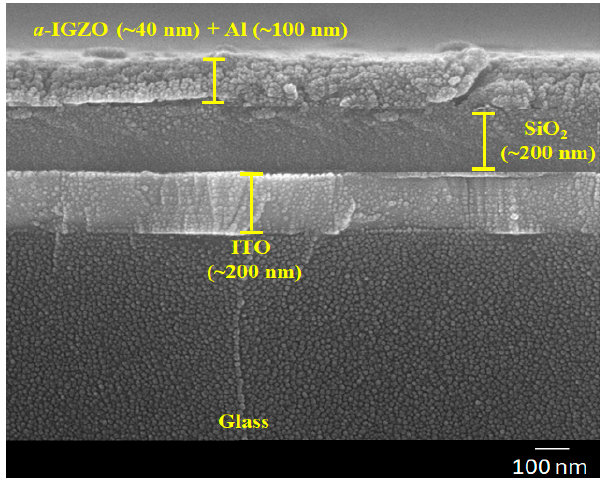
Figure 1. A cross ‐ section SEM image for the multiple films on glass substrate. Figure 1. A cross-section SEM image for the multiple films on glass